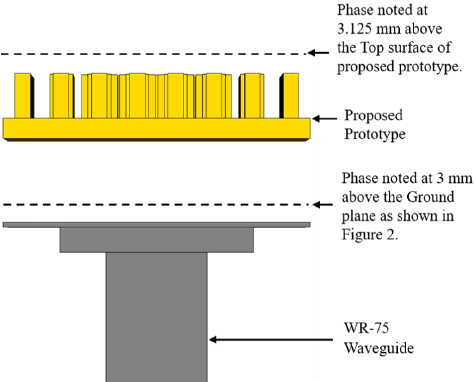
Figure 5. Overall system setup for the phase